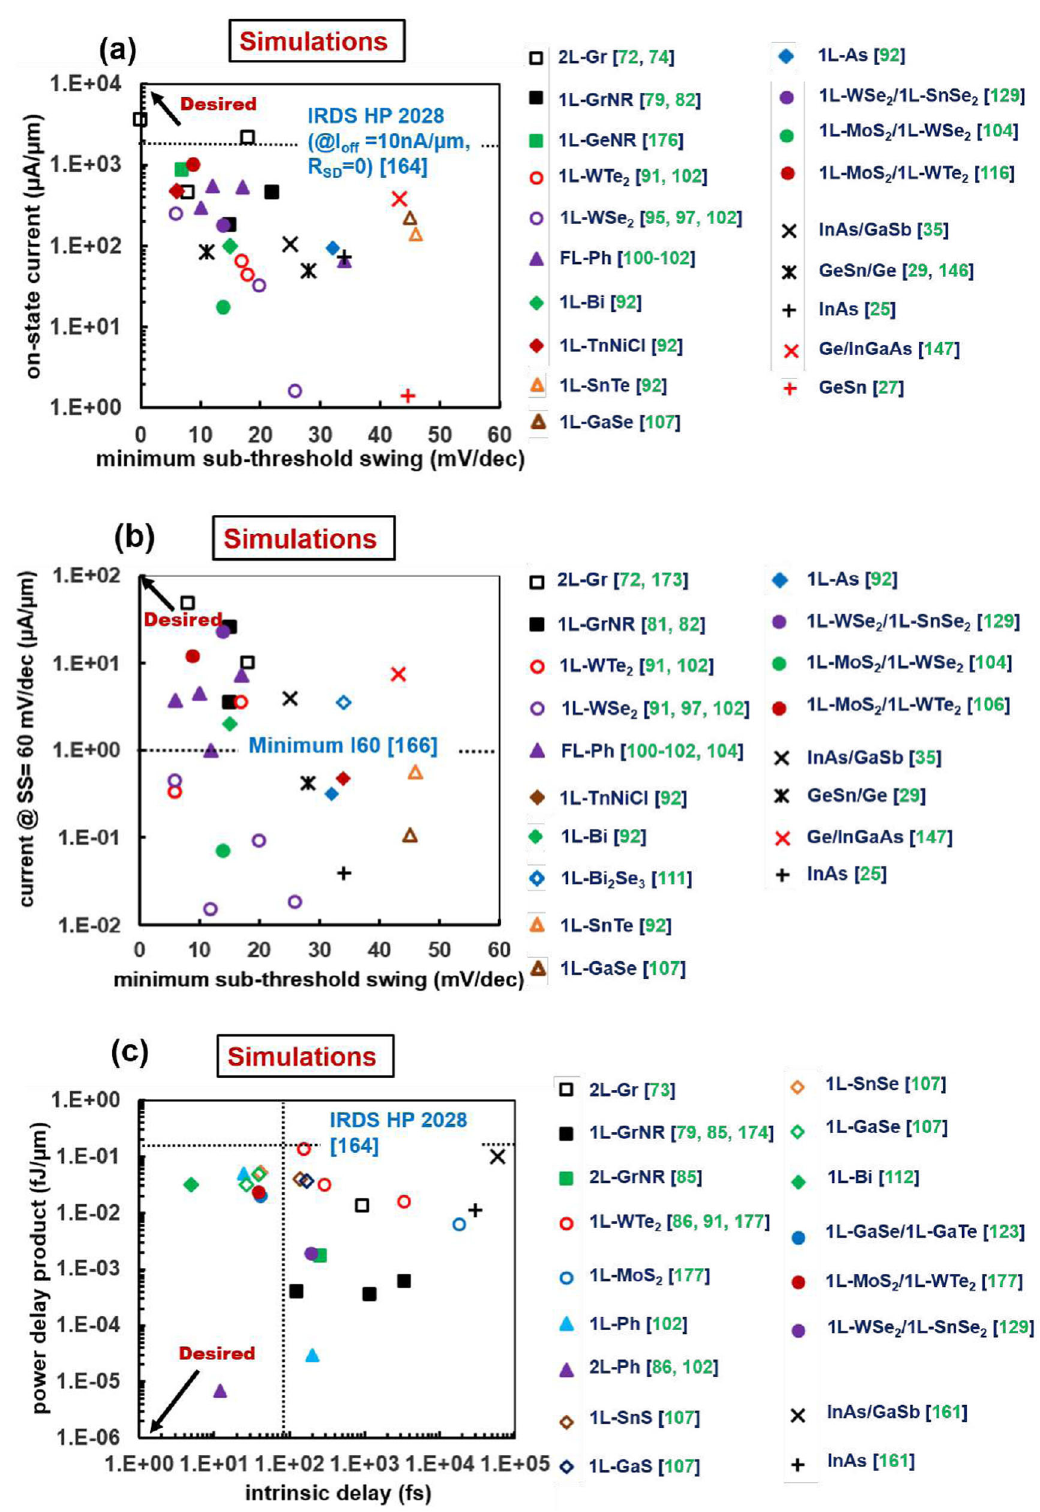
Fig. 28 Performance of Simulated Nanoscale 2D-TFETs. Comparative Plots of a I on – vs SS min b I 60 – vs SS min at 1 × 10 5 V/cm channel lateral electric fi eld (drain bias/channel length) and 0.5 V gate bias, c PDP – vs Intrinsic Delay for numerical device simulation based reported nanoscale (<50 nm channel length) 2D- and bulk-